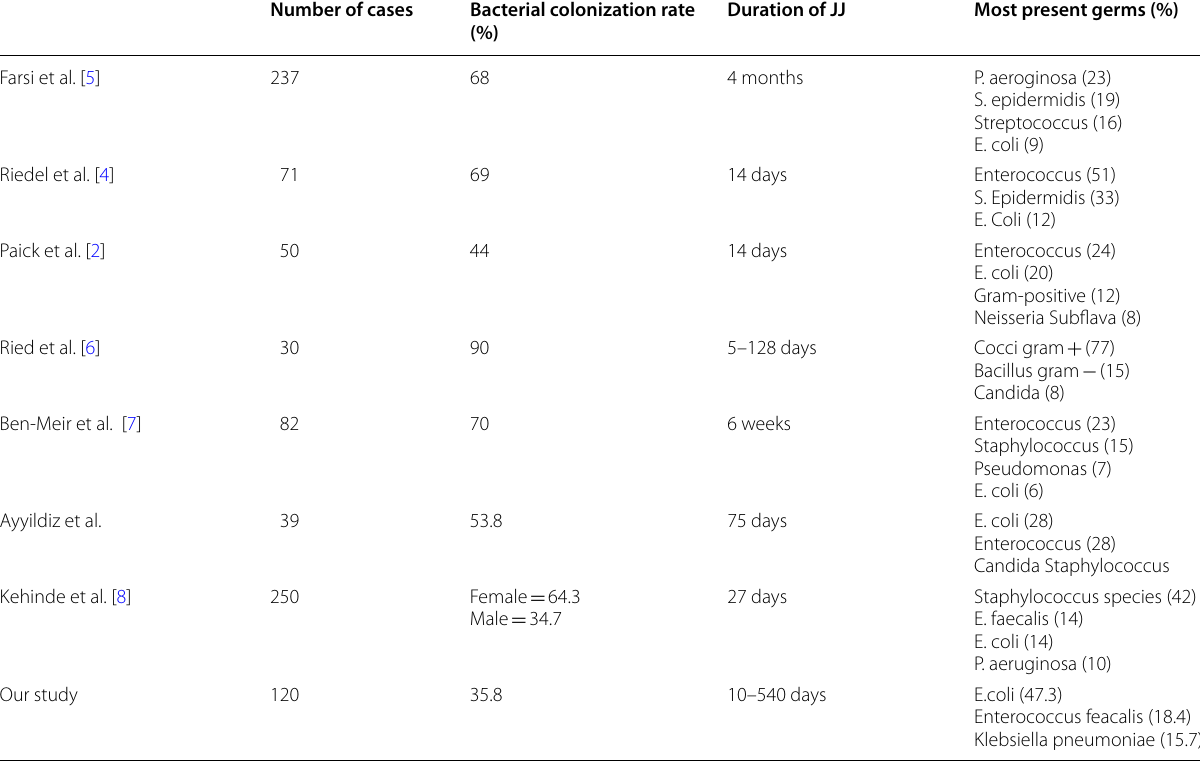
Table 6 Summary table of the various international series comparing the rate of bacterial colonization with our